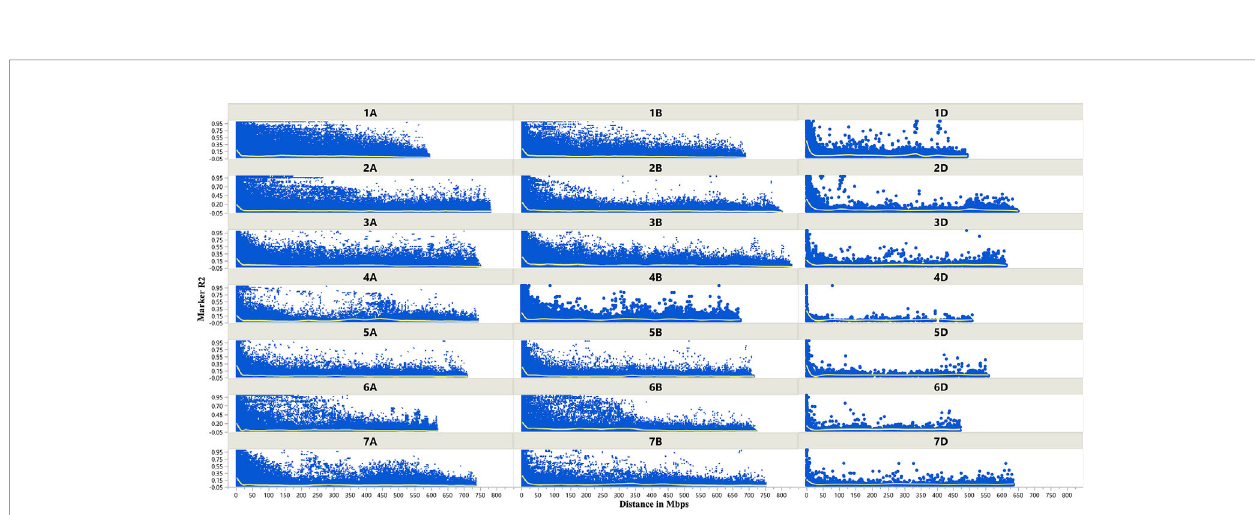
FIGURE 2 | Heatmap and dendrogram of Kinship matrix estmated using Van Randen algorithum based on 11,401 SNP markers and 184 wheat genotypes.